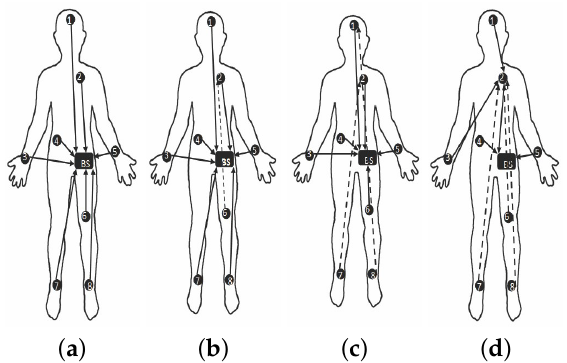
Figure 17. Typical network topology while sitting activity. ( a ) At TX 1 ; ( b ) At TX 2 ; ( c ) At TX 3 ; ( d ) At TX 4